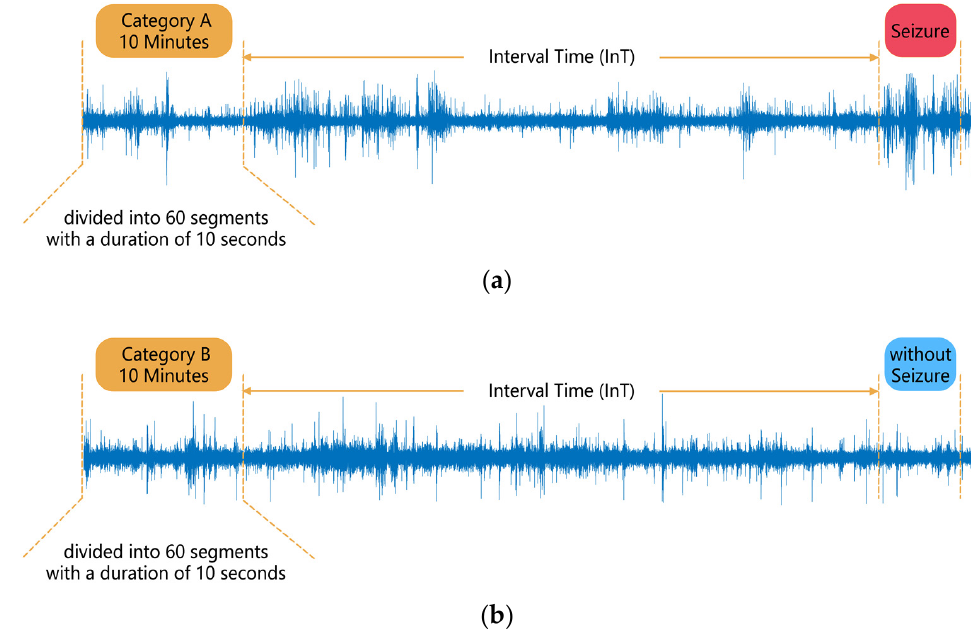
Figure 1. Segmentation of EEG data: ( a ) Category A data, ( b ) Category B data.